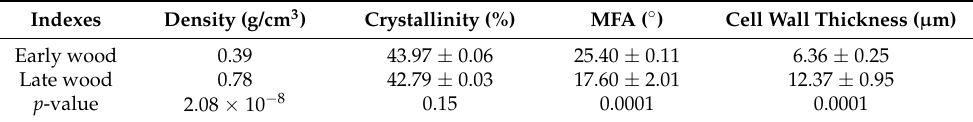
Table 2. Density, crystallinity, cell wall thickness, and MFA of earlywood and